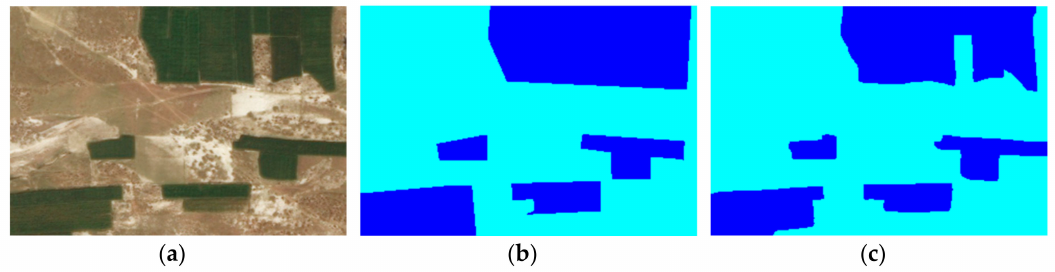
Figure 3. Example of visible structural inaccuracies in agriculture land (di ff erent image clusters are marked with selected colours): ( a ) satellite image “965977_sat_00000.png“ from our constructed dataset, ( b ) not corrected GT image of “965977_sat_00000.png,“ and ( c ) corrected GT image